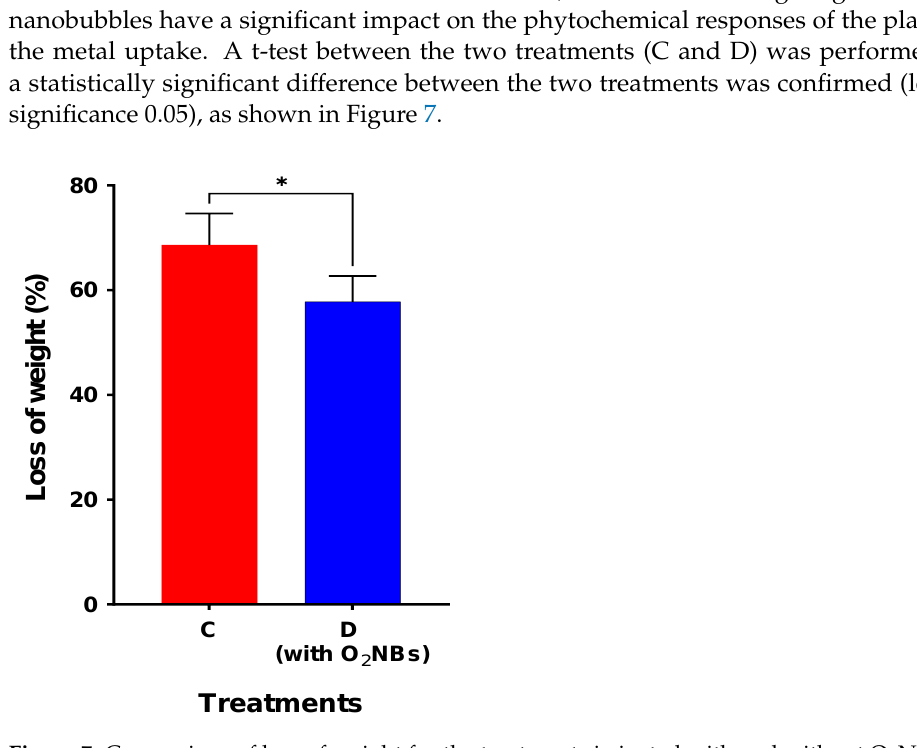
Figure 7. Comparison of loss of weight for the treatments irrigated with and without O 2 NBs (star indicates the level of significance: * for p < 0.05).